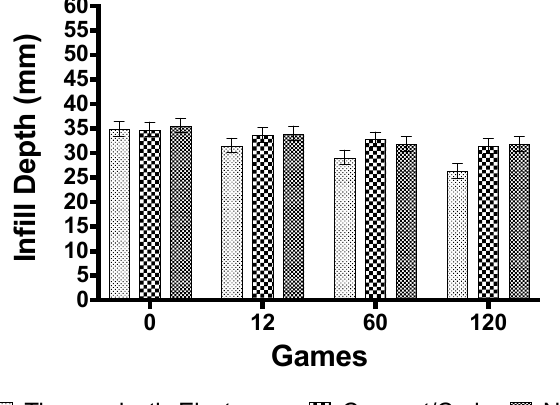
Figure 2. Infill depth of three alternative infills tested affected by the significant interaction of infill and games during 2017 in Knoxville, TN. Error bars represent standard error of the mean.